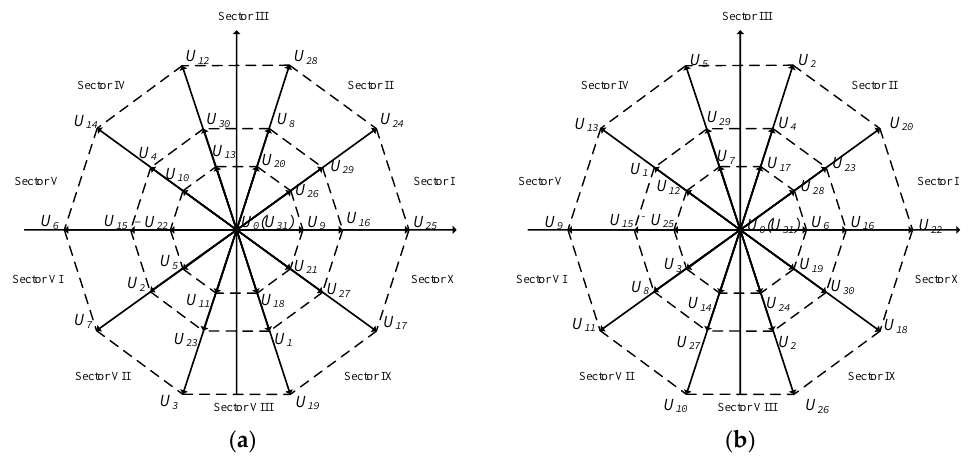
Figure 18. Space voltage vector distribution in the fundamental and third harmonic coordinate system. ( a ) Fundamental α 1 – β 1 coordinate system vector distribution. ( b ) third harmonic α 3 – β 3 coordinate system vector distribution.